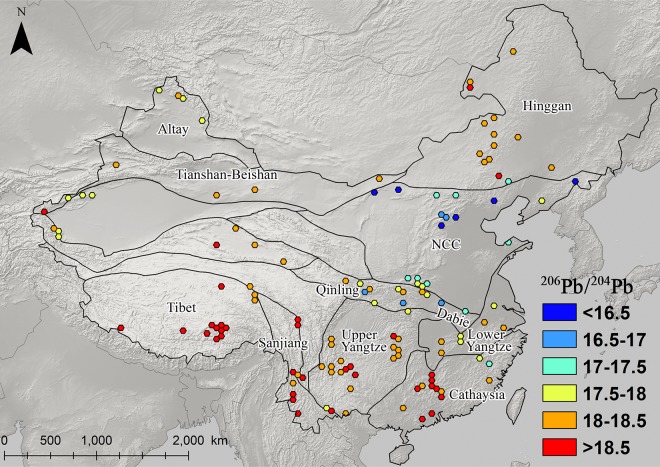
Map of 206Pb/204Pb ratios for galena ores (n = 2,104).Each color represents the median Pb isotope ratios in a 60 x 60 km hexagonal grid containing at least five measurements.